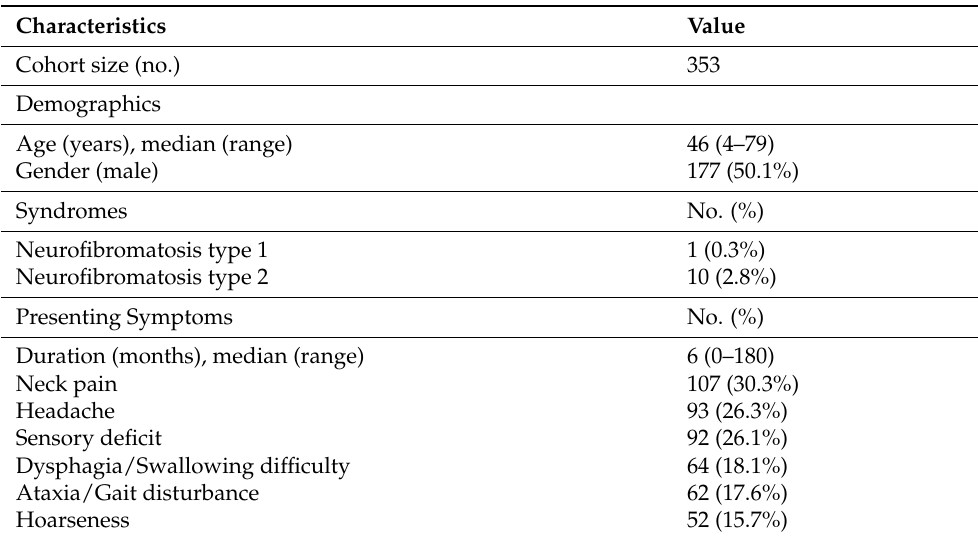
Table 1. Summary of demographics and clinical presentation.